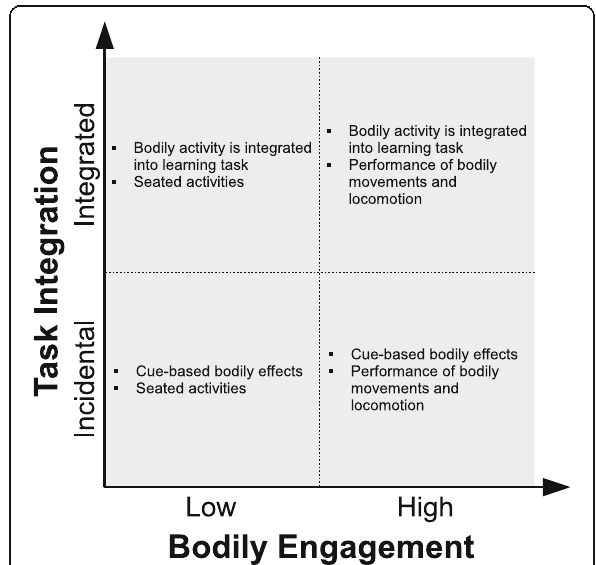
Fig. 1 The 2 × 2 grid resulting from the proposed taxonomy presented in the section “ Taxonomies of embodiment in education. ” The four quadrants correspond to combinations of the two dimensions bodily engagement (low vs high) and task integration (incidental vs integrated). Low bodily engagement in our taxonomy is comparable to the lower two levels of embodiment defined by Johnson-Glenberg et al. (2014), i.e. watching animations or other seated interactions. Correspondingly, high bodily engagement in our taxonomy is comparable to the higher two levels of embodiment defined